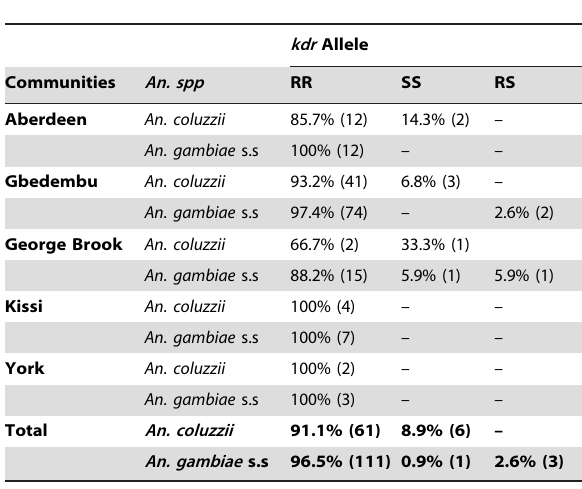
Table 2. The distribution of the kdr allele in the An. coluzzii and the An. gambiae s.s in